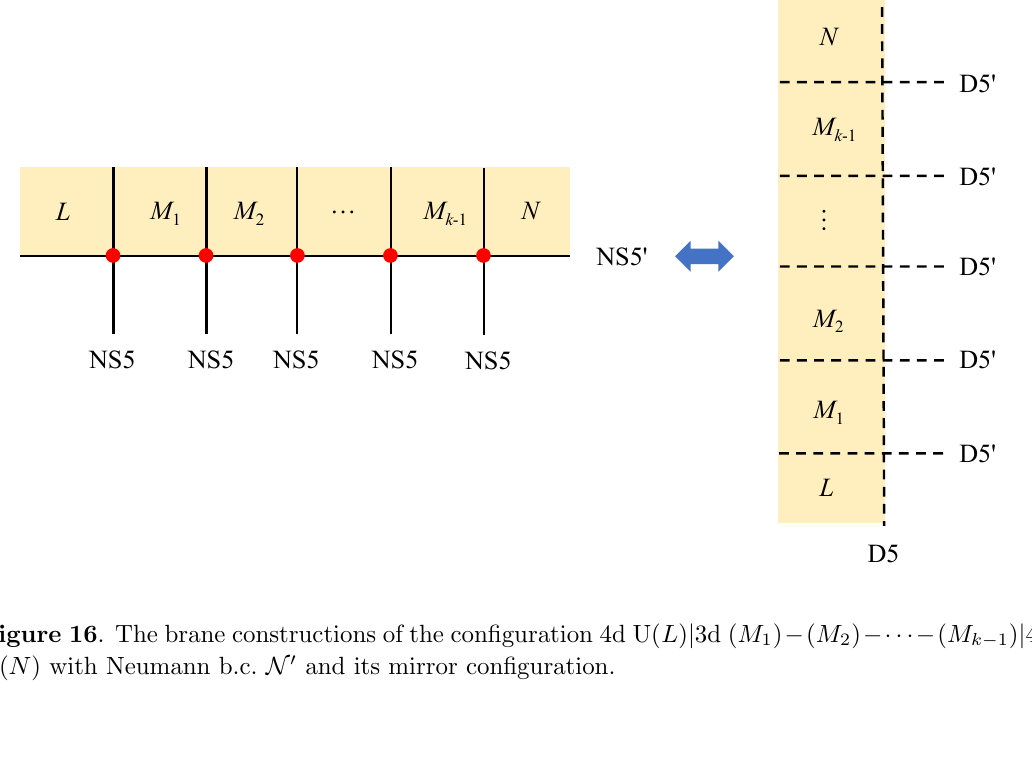
and its mirror N (cid:30)